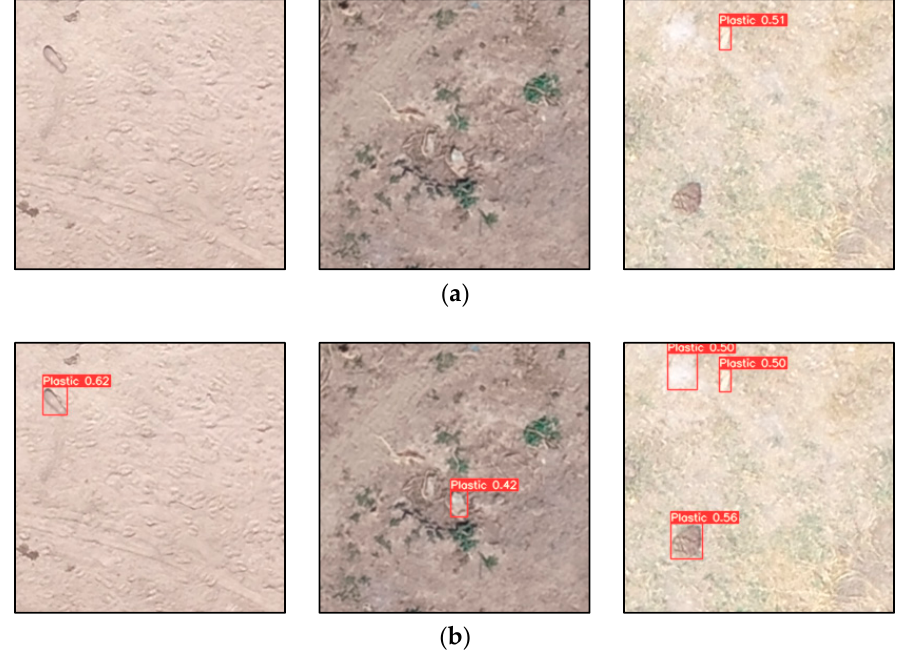
Figure 10. The TT model fine-tuned on HMH performs well in some cases. ( a ) HMH model result on HMH. ( b ) TT model results on HMH with fine-tuning.